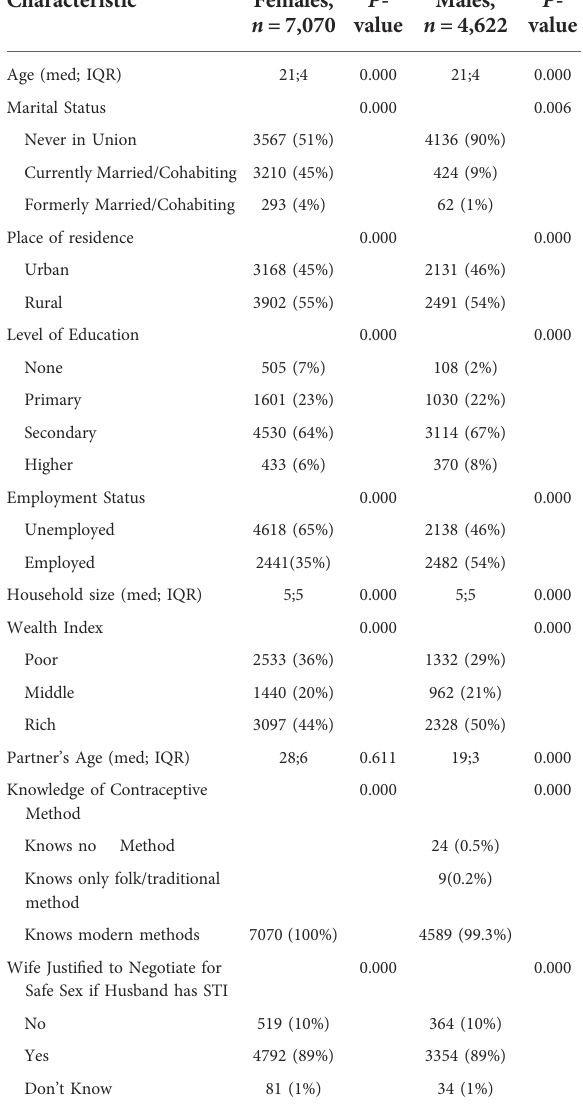
TABLE 3 Distribution of characteristics for users of modern contraceptives by gender.